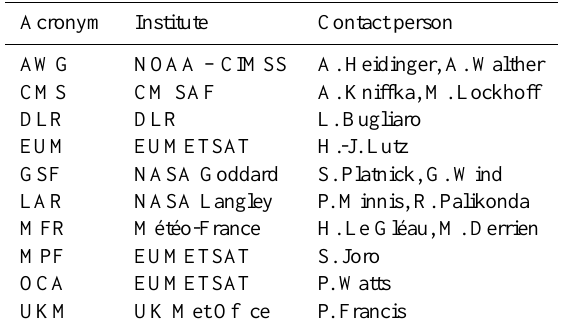
Table 2. Days and core hours of the CREW database.